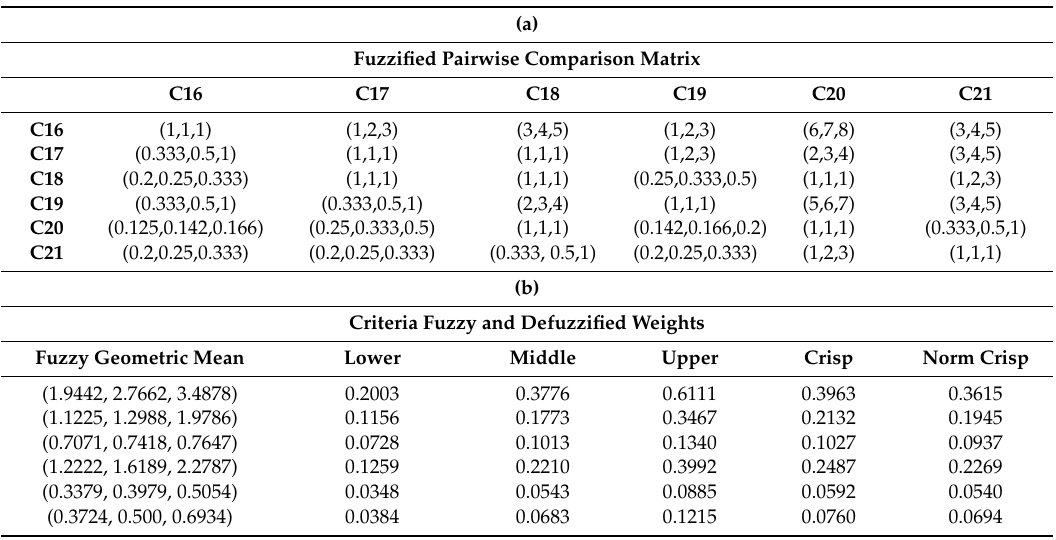
Table 9. SF-AHP results per criteria category for the category social. ( a ) Fuzzified pairwise comparison matrix; ( b ) Criteria fuzzy and defuzzified weights.